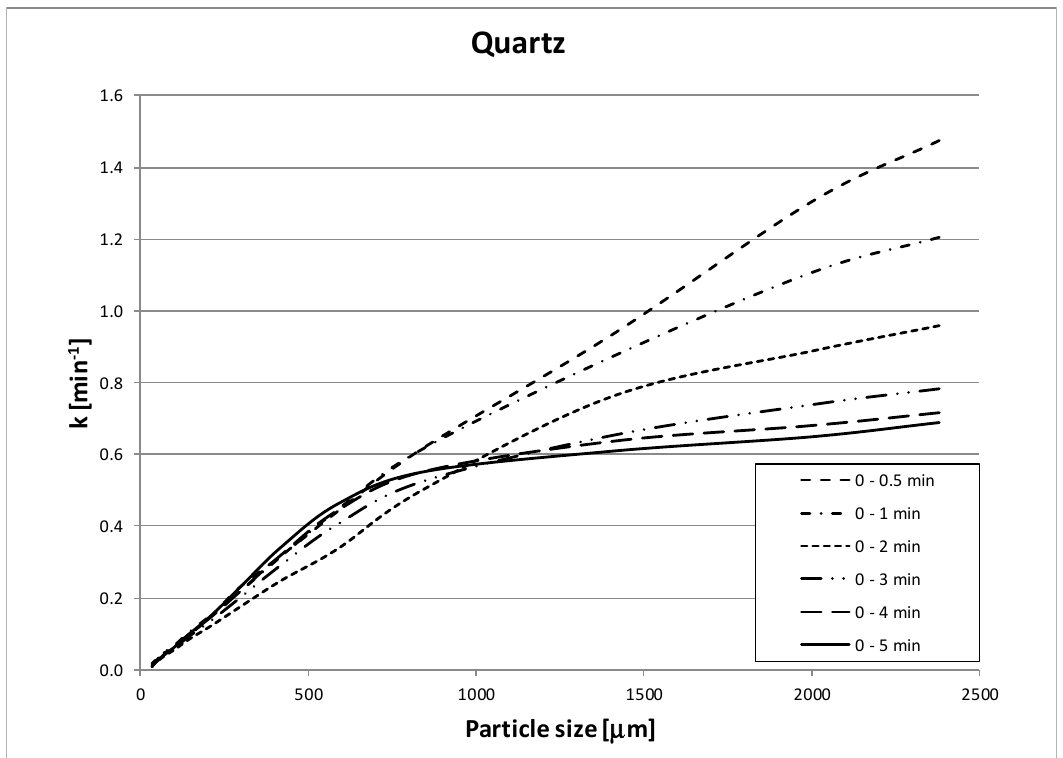
Figure 2. Graph showing the variation of k with particle size for di ff erent grinding times, in the case of quartz.